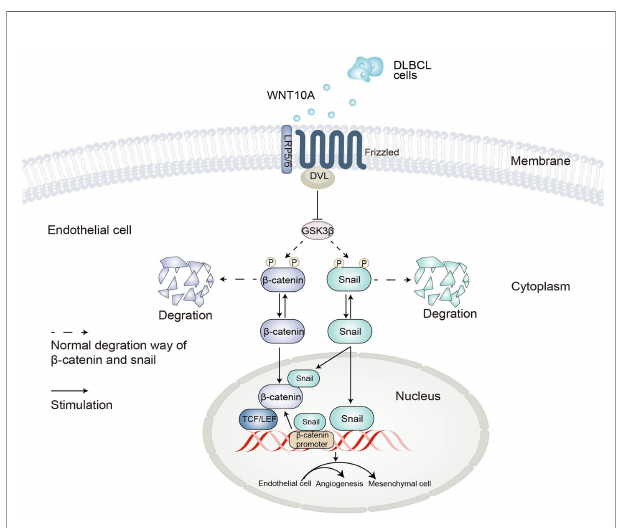
FIGURE 7 | Schematic representation of the proposed mechanisms underlying DLBCL-induced angiogenesis and endothelial-to-mesenchymal transition. DLBCL, diffuse large B-cell